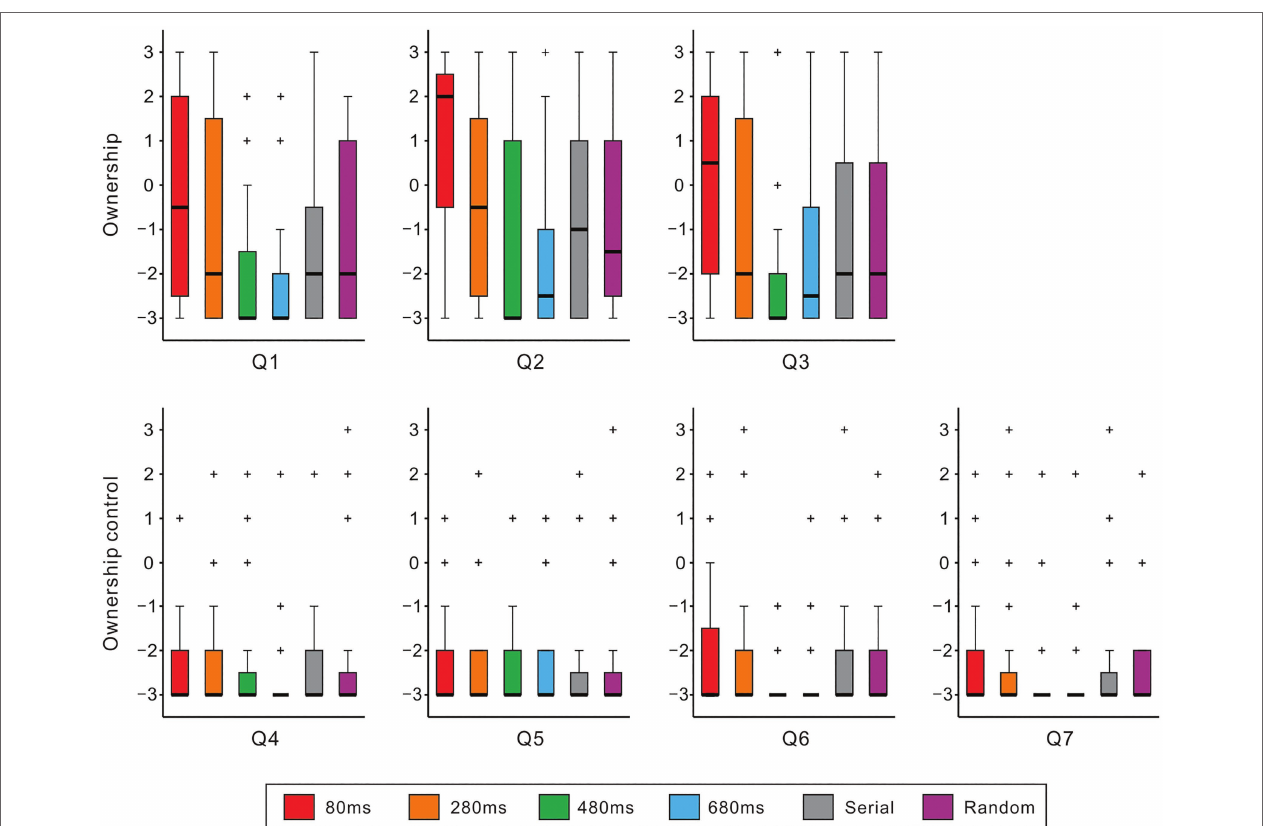
FIGURE 2 | Questionnaire rating. Boxplots of questionnaire ratings of six experimental conditions with different colors are shown for ownership (top panels: Q1–Q3) and ownership control (bottom panels: Q4–Q7). Boxes and thick lines denote the interquartile ranges (IQRs) and medians, respectively. Whiskers show either additional data points or extend to 1.5 × IQR. Small plus signs indicate